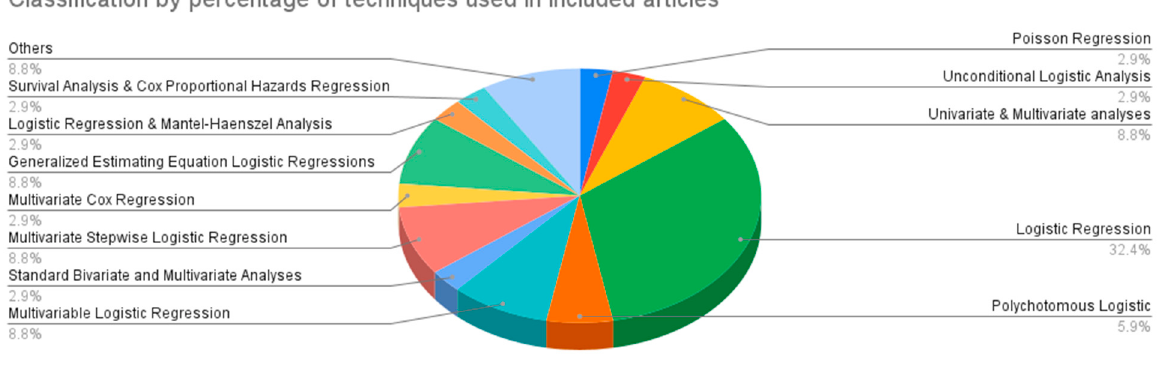
Figure 4. The classification by percentage of techniques used in included articles.